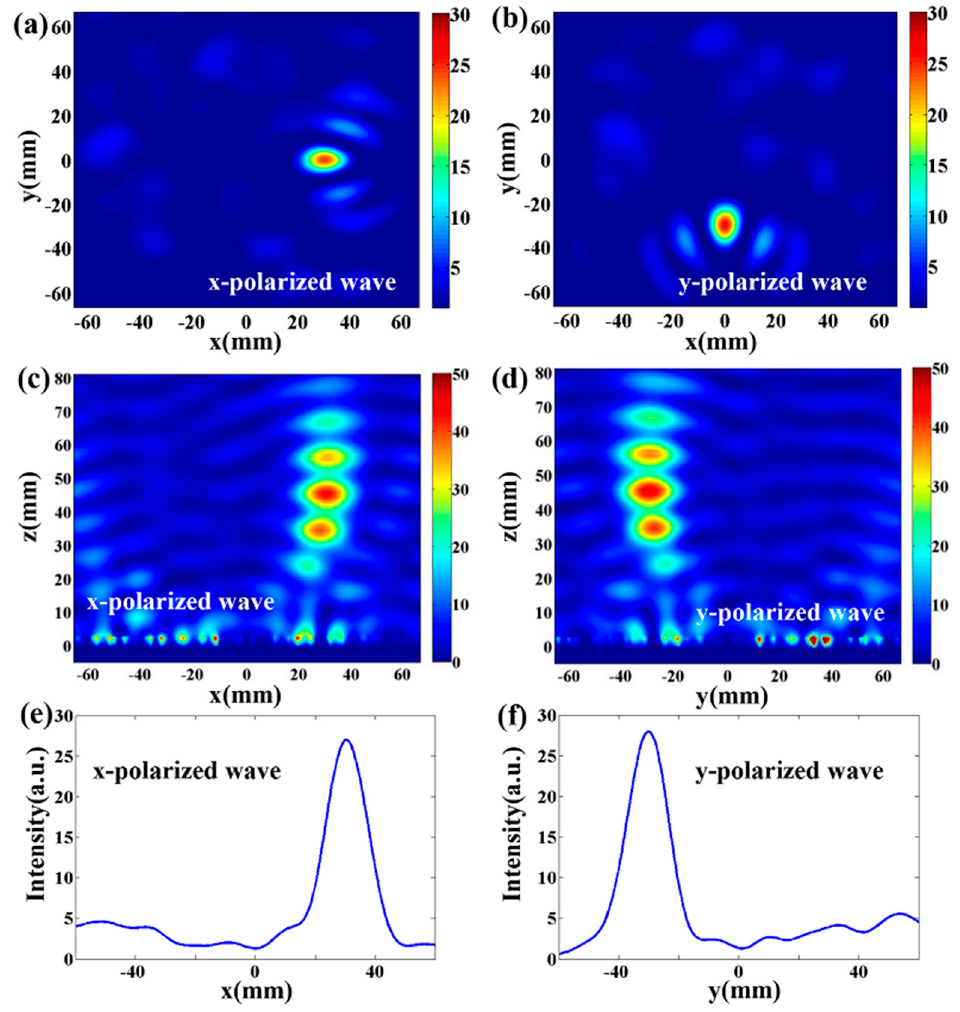
Figure 7. Electric distribution in the x – y plane at z = 40 mm for ( a ) x - ( b ) y -polarized incident waves. Electric distribution in the x – z and y – z planes for ( c ) x - ( d ) y -polarized incident waves, respectively. Intensity profile at a focus spot along the ( e ) x - ( f ) y -axis for incident x - and y -polarized waves.